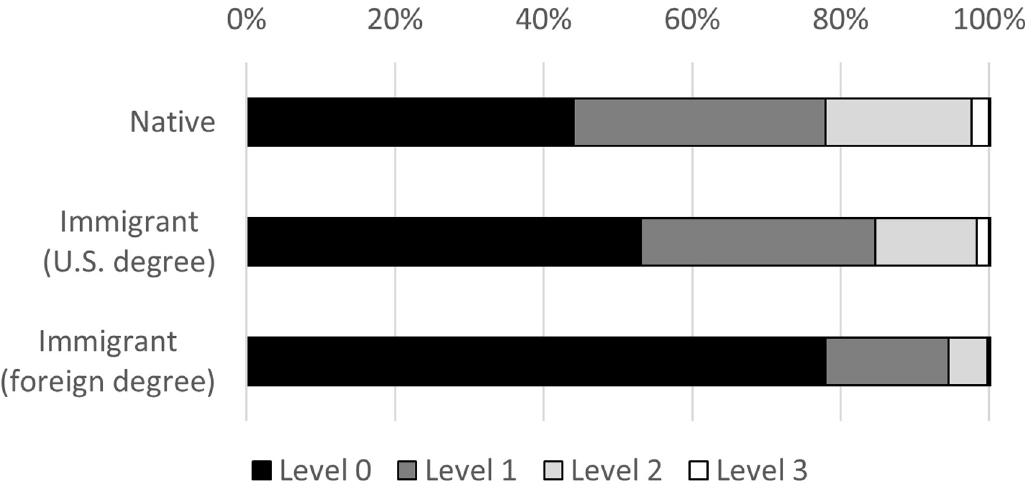
Fig 6. Distribution of PIAAC PSL category scores, education = high school. The figure displays the percentage scoring at four different levels of the PST test. Higher levels require more sophisticated problem solving. The percentages are not